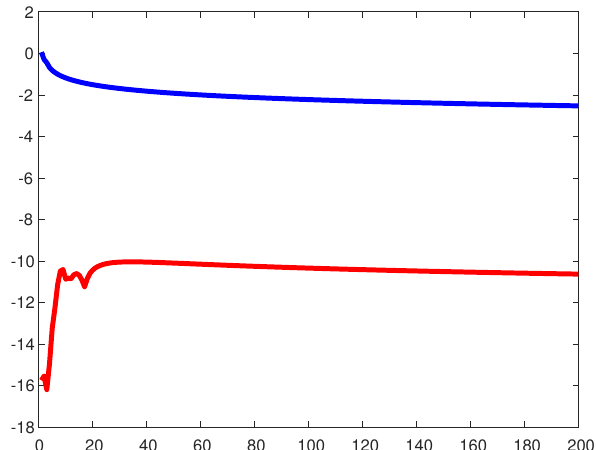
Figure 2. The test function ( left ) and the spline approximation error ( right ).